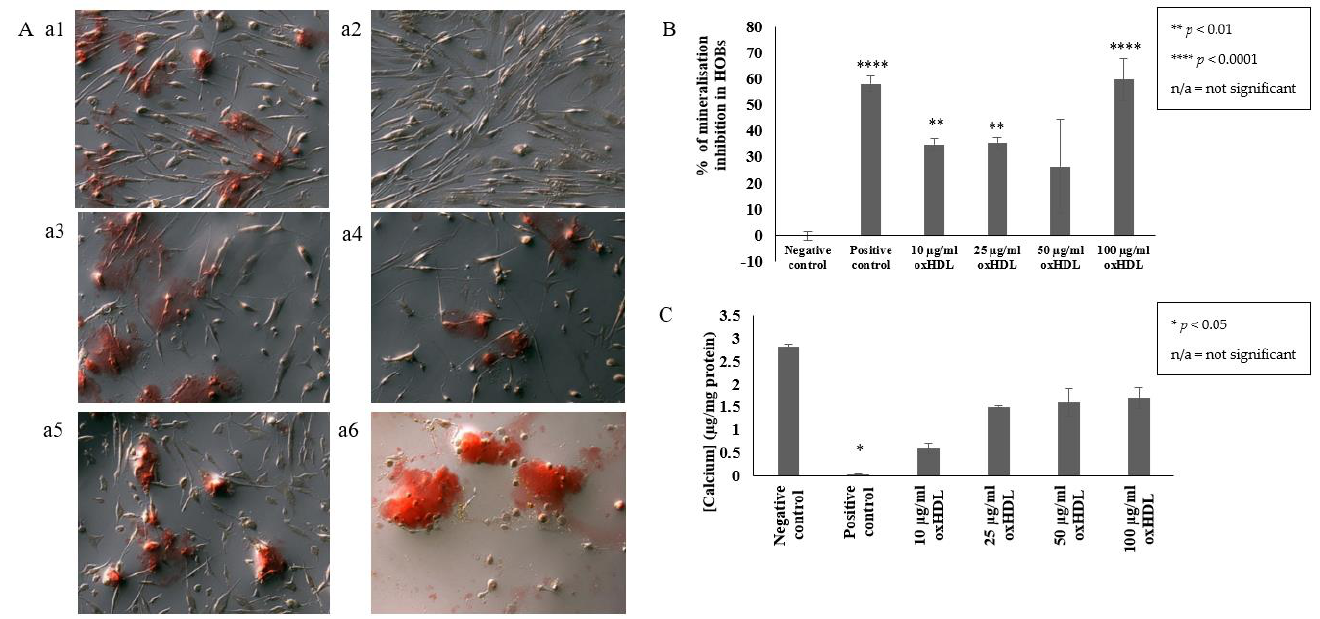
Figure 1. Effects of oxHDL on mineralization and calcification in HOBs. ( A ) Cell morphology and formation of mineral nodules. The pictures were captured at 10 × magnification using a phase-contrast microscope (Olympus IX81 microscope). HOBs were incubated with ( a1 ) culture medium (negative control); ( a2 ) inorganic pyrophosphate (positive control); and ( a3 ) 10, ( a4 ) 25, ( a5 ) 50, and ( a6 ) 100 µg/mL protein oxHDL, for 14 days. The medium was changed for every 3 days. HOBs were stained with 2% alizarin red for the detection of mineral nodules indicated by the presence of red color. ( B ) The percentage of mineralization inhibition in HOBs was quantified by measuring the concentration of Alizarin red staining in the cells. ( C ) Calcium deposition was analyzed using a calcium colorimetric assay. Data are expressed as mean ± SEM of duplicate readings. * p < 0.05, ** p < 0.01, **** p < 0.0001 compared to the negative control. Non-available (n/a) indicates not significant.